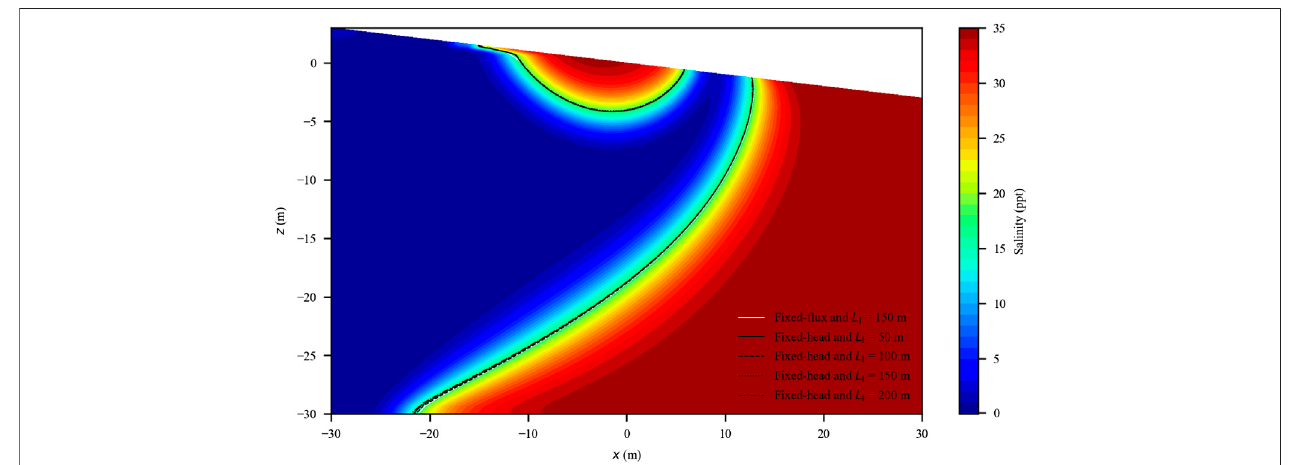
FIGURE2| Two-yearaveragedsalinitydistributionintheaquifer(notethatonlythebeachsectionispresented).Thesalinityisshownbydifferentcolors(thecaseof fi xed-head ( L (cid:1) 50 m) was used). The different types of lines represent the 50% isohaline of the seawater for the different cases (largely overlapped). The salinity I distributions are similar in the cases with fi xed- fl ux ( L I (cid:1) 150 m) and fi xed-head ( L I (cid:1) 50, 100, 150, and 200 m) inland boundaries.